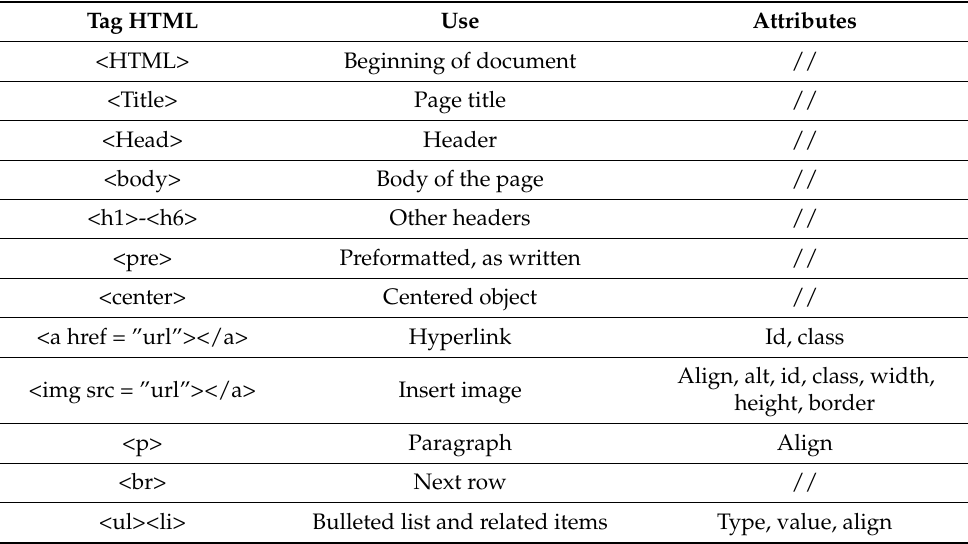
Table 3. Main tags and attributes of a HTML web